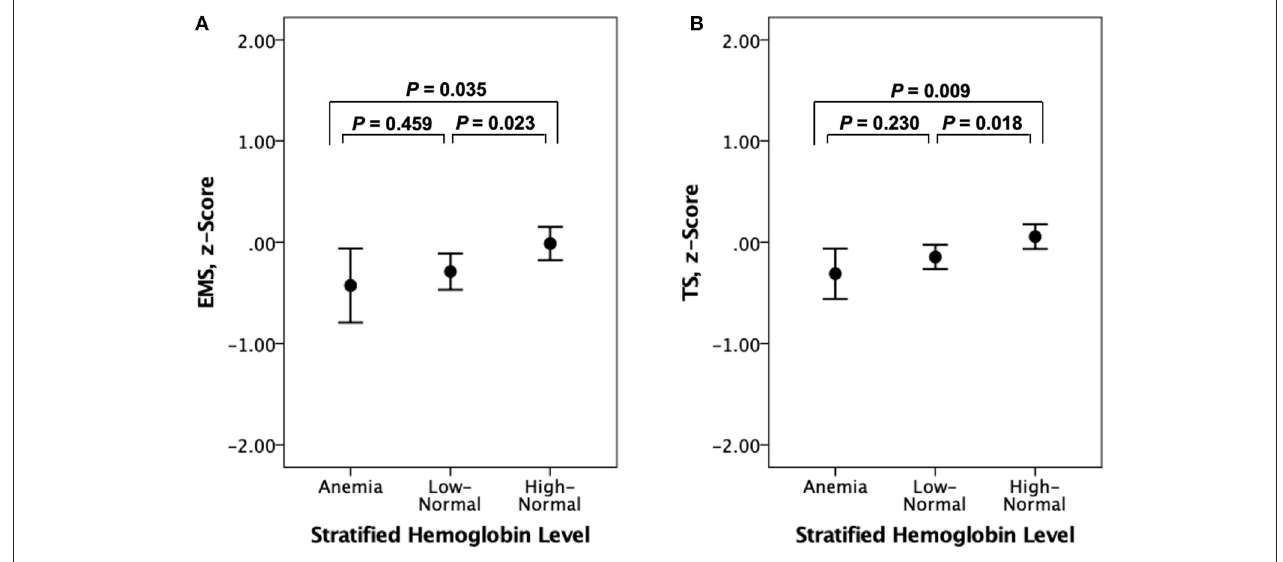
FIGURE 3 | Error bar charts displaying (A) episodic memory score (EMS) and (B) CERAD total score (TS) according to stratified hemoglobin levels in non-demented older participants. Error bars indicate standard